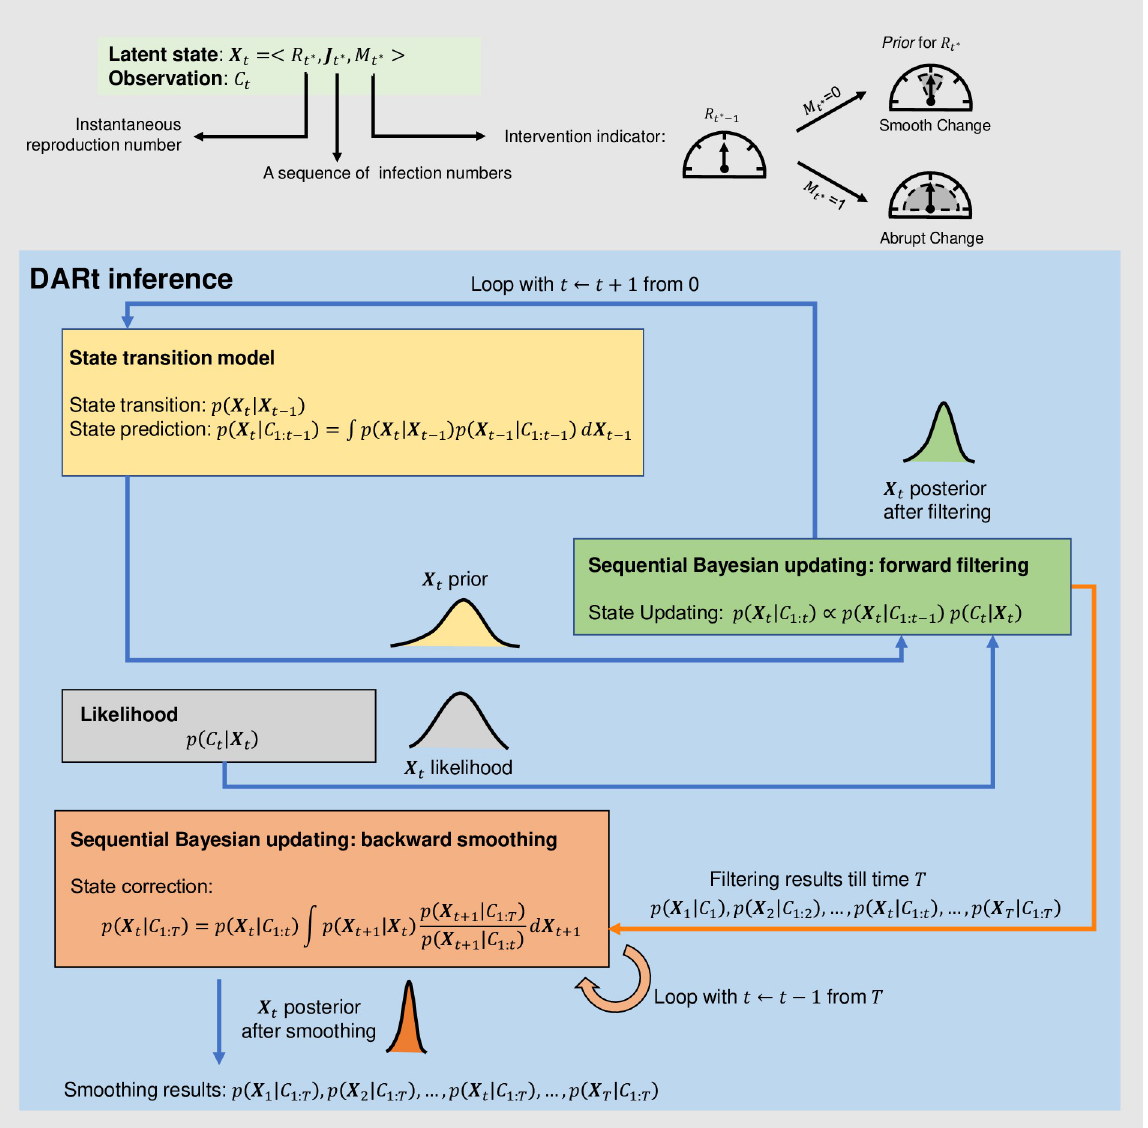
Fig 5. Three components of DARt inference model: state transition model, observation function and sequential Bayesian update module with two phases (forward filtering and backwardsmoothing). The latent state that can be observed in C instantaneous reproduction number, M t � is a binary state variable indicating different evolution patterns of R t � , J vectorised form of infection numbers j t , t � indicates the most recent infection that can be detected at time t is from the time t � due to observation delay, is the length of the vector J and T φ